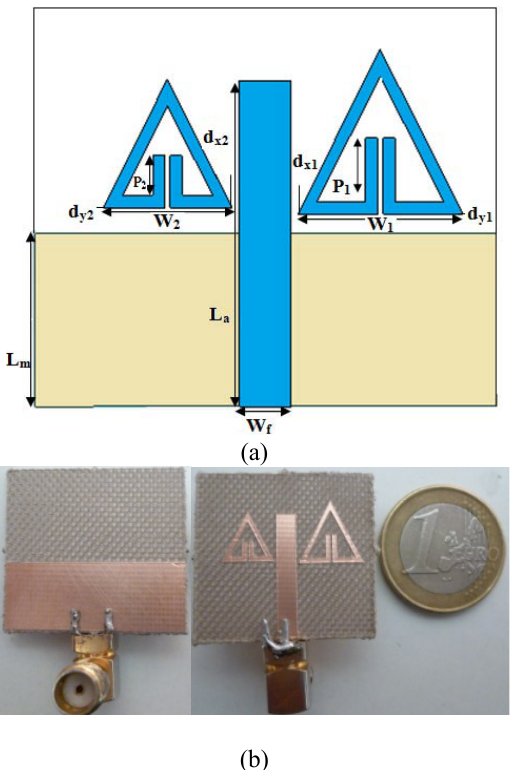
Fig.7 Simulation results of various antennas